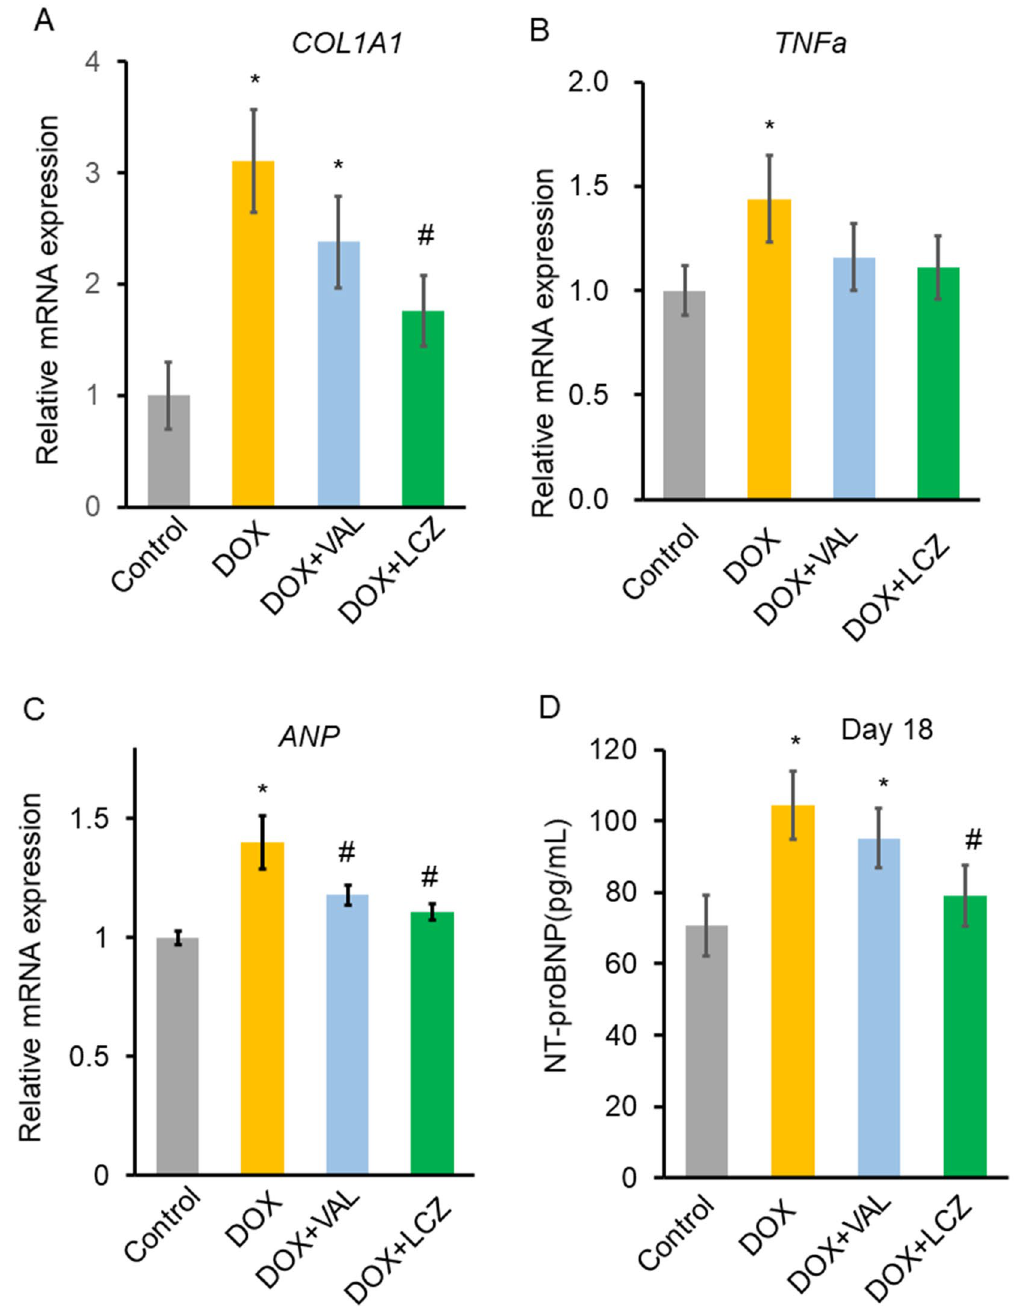
Figure 5. Effect of valsartan and LCZ696 on the mRNA expression of collagen, tumor necrosis factor-alpha (TNFa), and atrial natriuretic peptide (ANP) in the rat heart, and on serum N-terminal pro-brain natriuretic peptide (NT-proBNP) levels in DOX-treated rats. ( A ) Real-time PCR to check for the expression of COL1A1 mRNA on day 18. The DOX-induced increase in the mRNA levels of COL1A1 was significantly suppressed by LCZ, but not VAL. n = 10–15 in each group. ( B ) Real-time PCR analysis of TNFa mRNA on day 18. The DOX- induced increase in the mRNA levels of TNFa was not reduced by VAL or LCZ significantly. n = 10–15 in each group. ( C ) Real-time PCR to check for the expression of ANP mRNA on day 18. The DOX-induced increase in the mRNA levels of ANP was significantly suppressed by VAL or LCZ. n = 10–15 in each group. ( D ) Serum NT-proBNP level was significantly increased upon DOX treatment. LCZ, but not VAL, significantly reduced the serum NT-proBNP levels that were increased upon DOX treatment. n = 10–15 in each group. Data are expressed as the mean ± standard error. * p < 0.05 versus control and # p < 0.05 versus DOX. DOX, doxorubicin; VAL, valsartan; LCZ, LCZ696; COL1A1, collagen type I alpha 1; TNFa, tumor necrosis factor-alpha; ANP, atrial natriuretic peptide; NT-proBNP, N-terminal pro-brain natriuretic